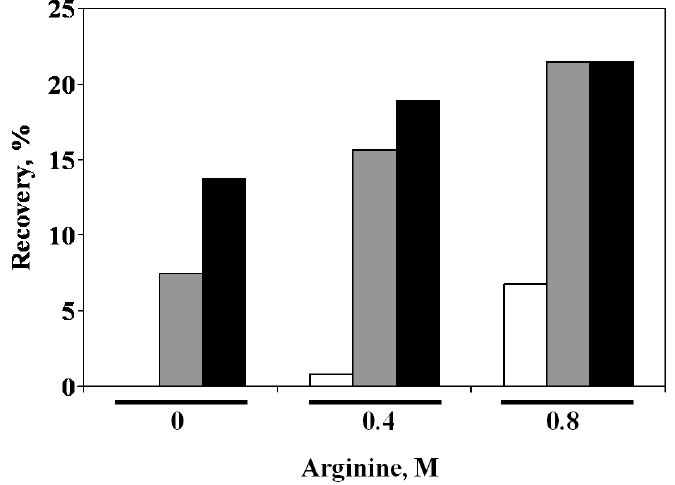
Figure 9. Refolding of anti-fluorescein scFv as a function of C12- L -Glu and arginine concentrations. White bar, 0.05% C12- L -Glu. Gray bar, 0.2% C12- L -Glu. Black bar, 0.4% C12- L